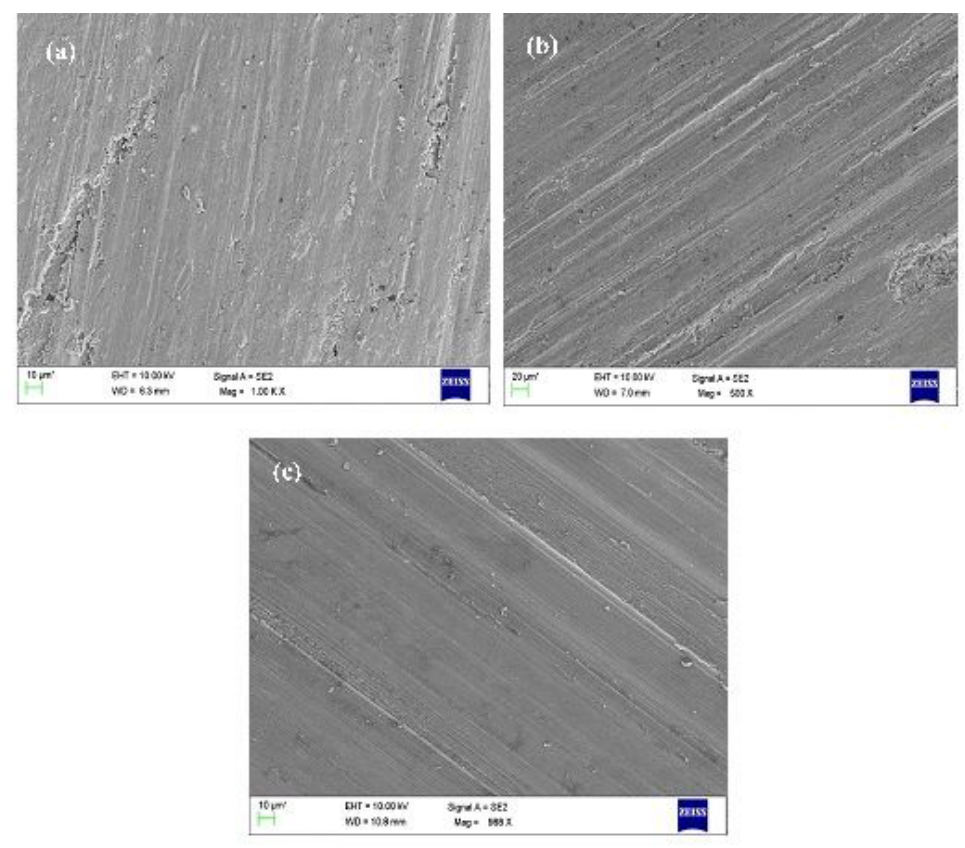
Figure 6: Typical wear surface at applied load of 19.6 N and sliding speed of 3.06 m/s and sliding distance of 1000 m (a) base alloy; (b) mono composite; (c) hybrid